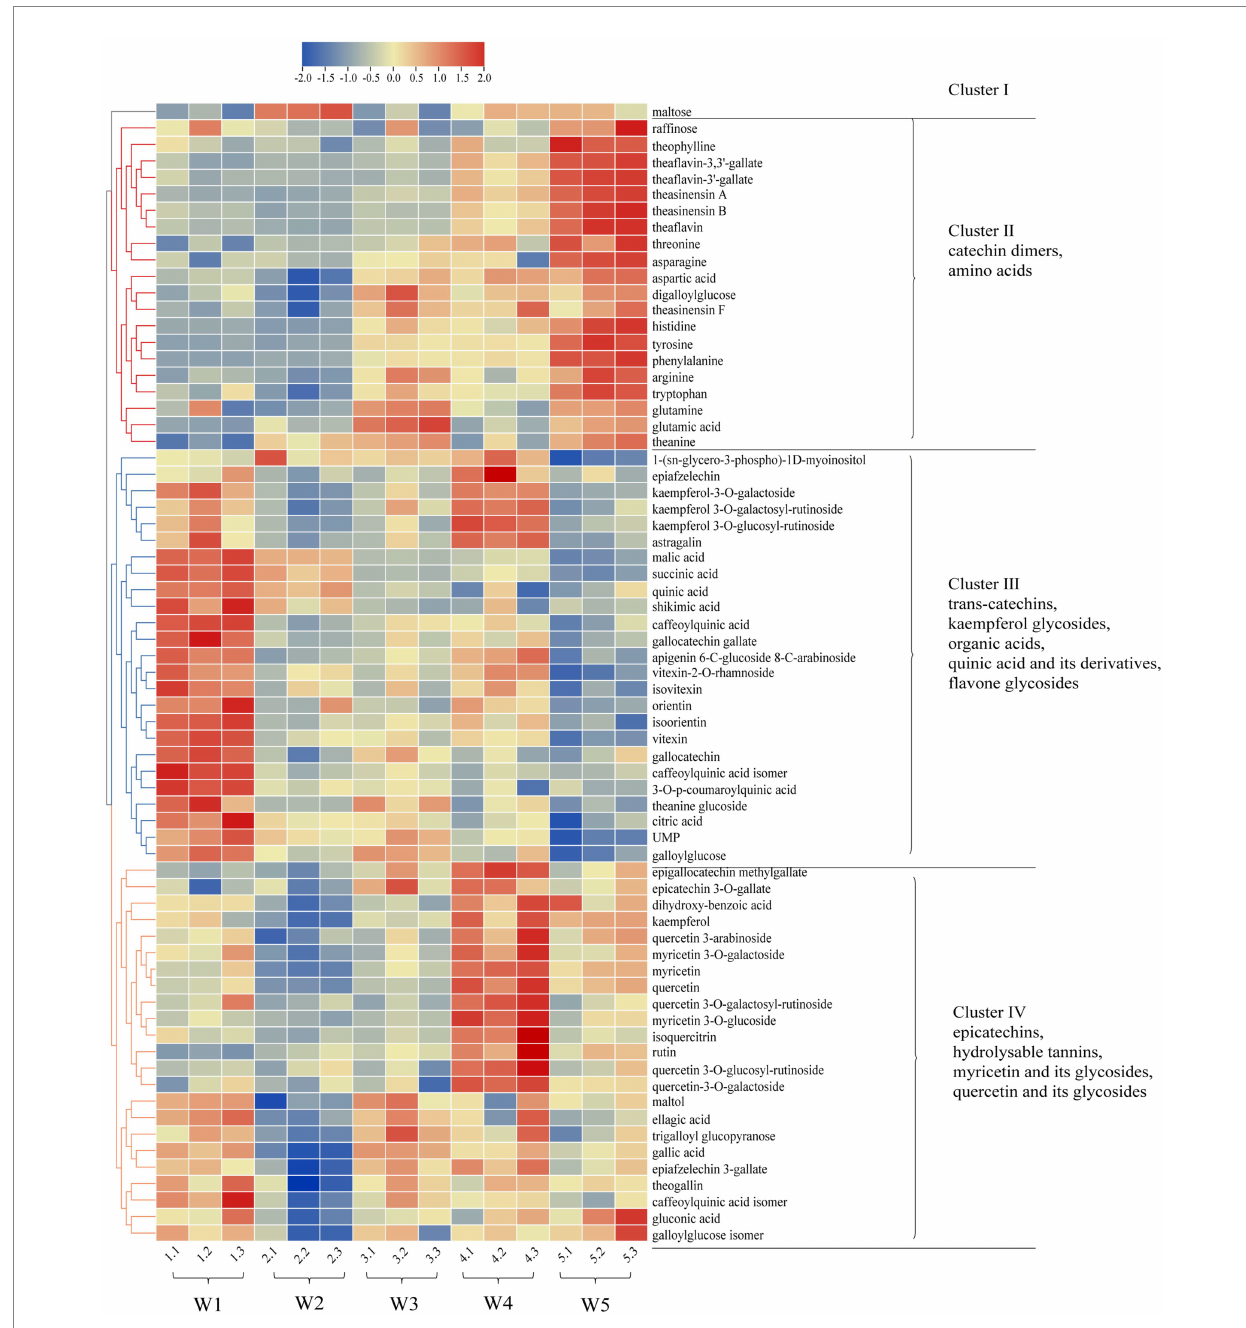
FIGURE 4 Heatmap of the 69 differential compounds in Longjing tea samples with different withering degrees. Red and blue colors indicate metabolite levels above and below the average of all samples at different withering degrees, respectively. Data are shown as the mean of the relative intensities of three replicates after unit variance (uv) scaling. Hierarchical clustering was performed based on Pearson